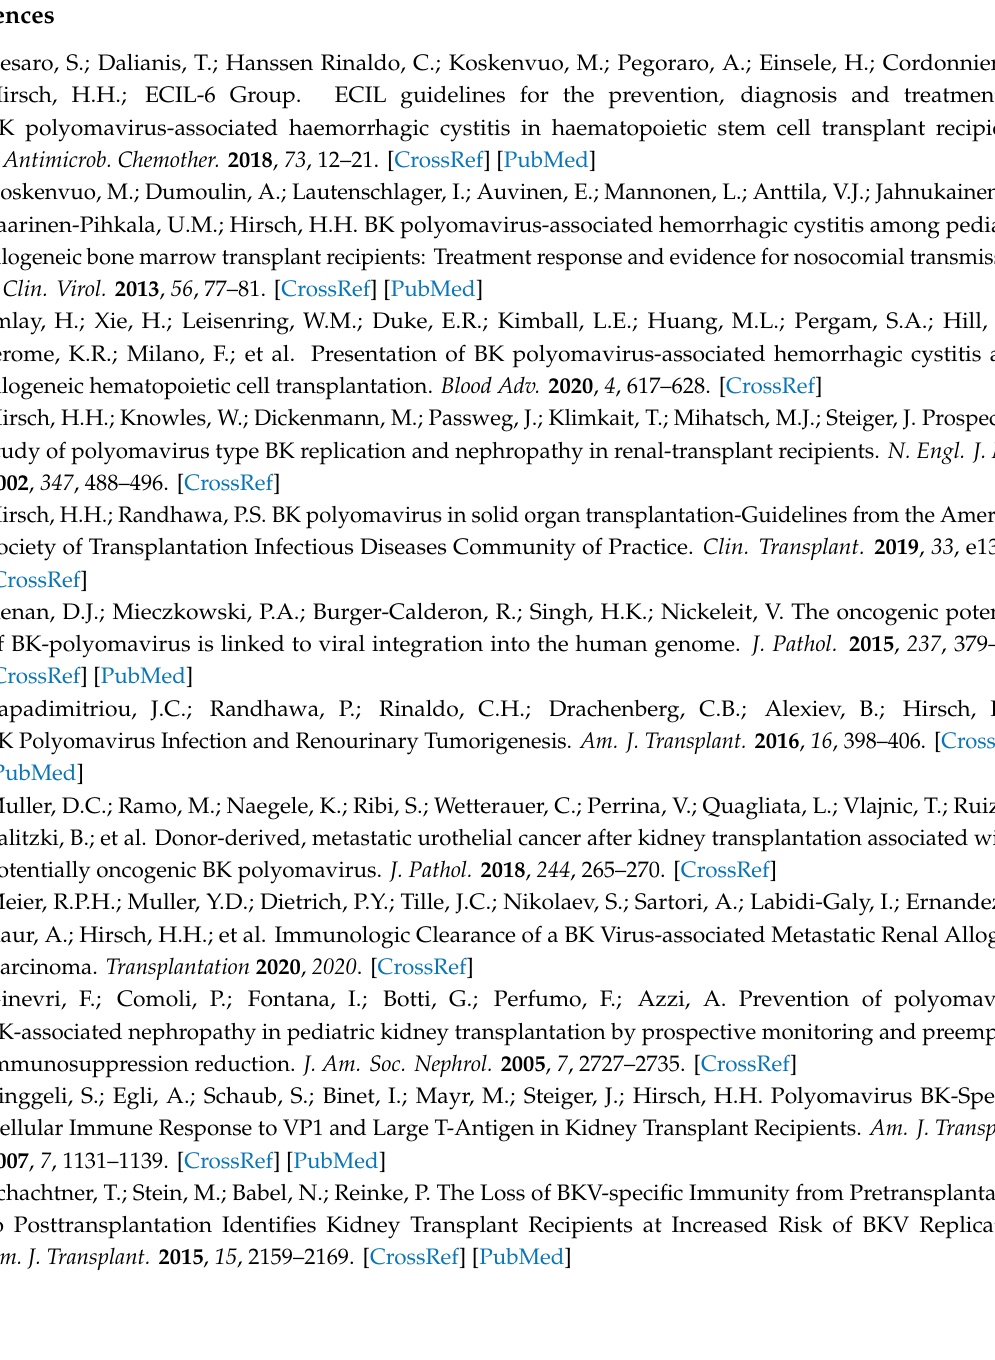
Figure S1. LTag sequence conservation among BKPyV subtypes; Figure S2. BKPyV LTag-9mer T-cell immune escape map. Table S1. Sequence conservation of BKPyV